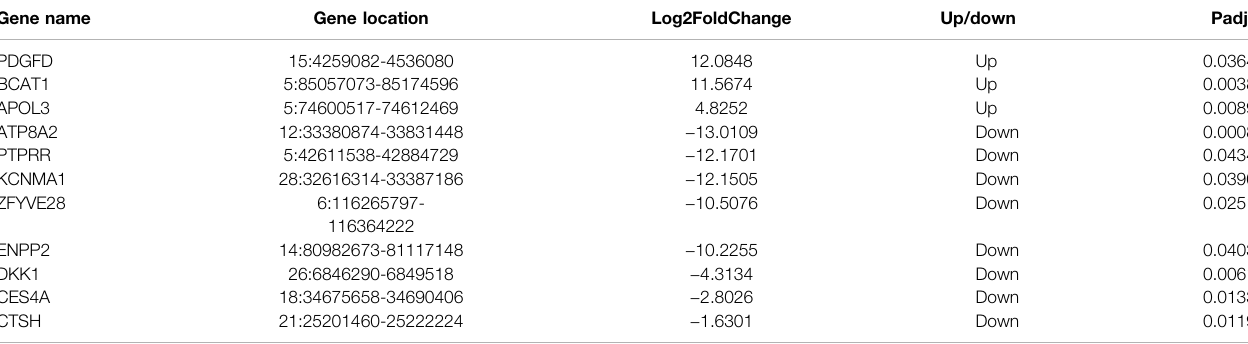
TABLE 3 | Candidate DEGs related to milk fat metabolism. Gene name